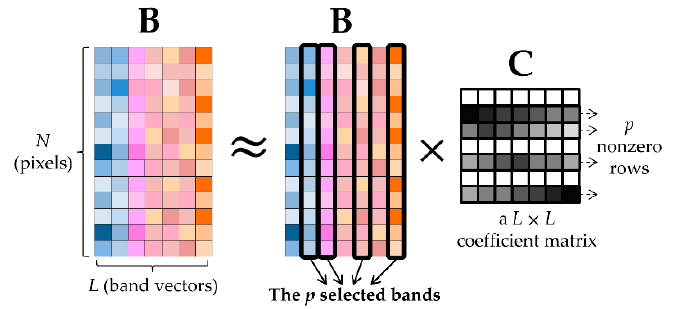
Figure 1. The concept of SSR model for BS.